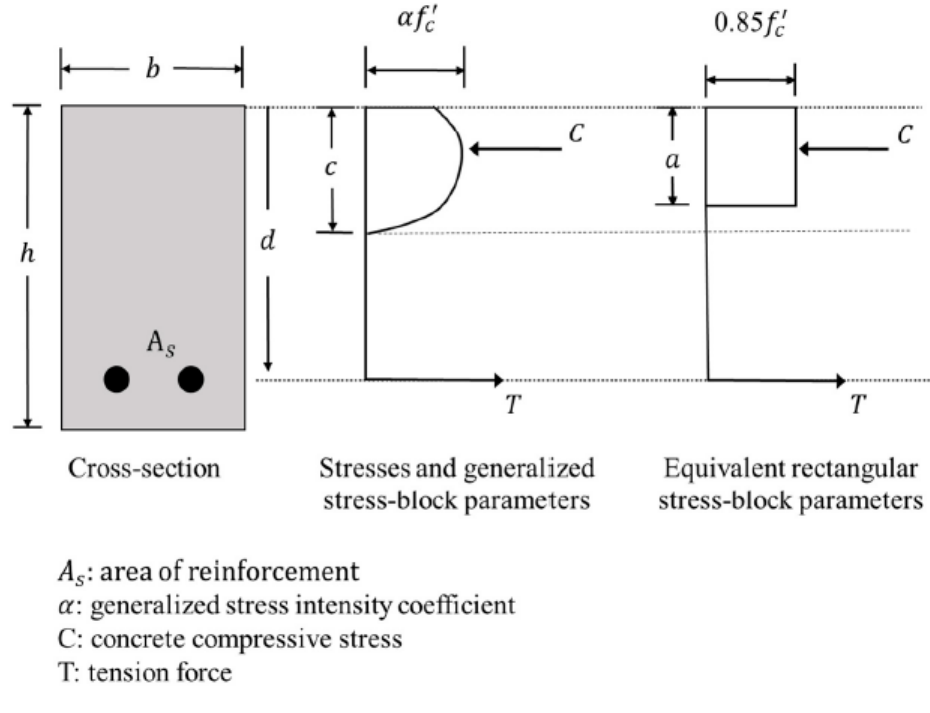
Figure 14. Definition of rectangular stress